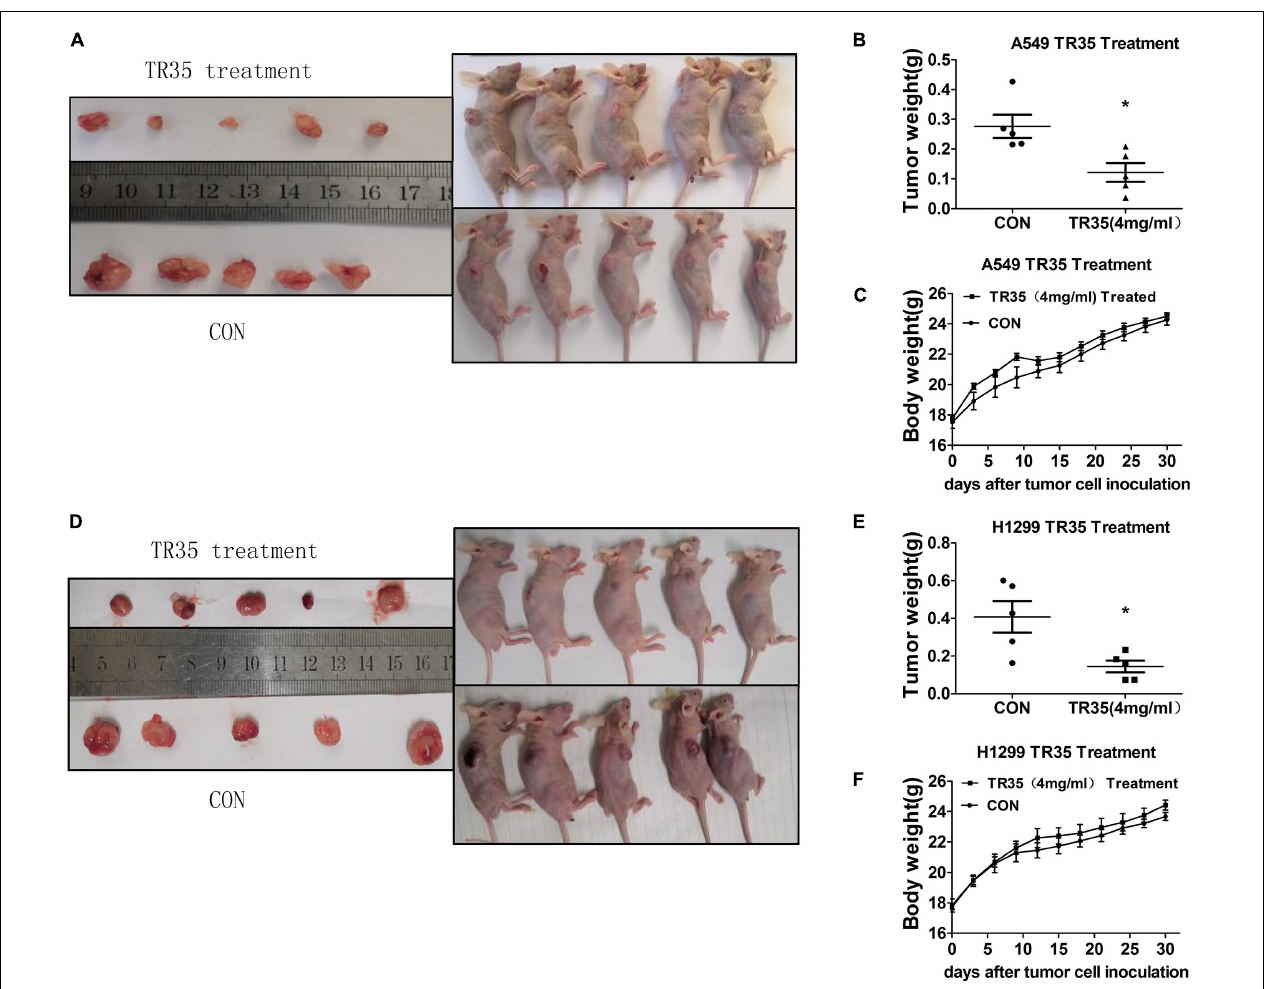
FIGURE 4 | The inhibitory effect of TR35 intragastric feeding on the growth of lung cancer xenograft in nude mice. Equal amounts of A549 and H1299 cells were inoculated under the skin of the back of nude mice. (A,D) After TR35 treatment, the animal images of unresectable tumors and tumor images of resected tumors were obtained in animals injected with different cell lines. (B,E) The comparison of tumor weights of two groups in animals injected with different cell lines. (C,F) Animal weight was recorded once every 3 days in animals injected with different cell lines. Data are presented as the mean ± SEM, n = 5 (* p < 0.05 vs. CON).